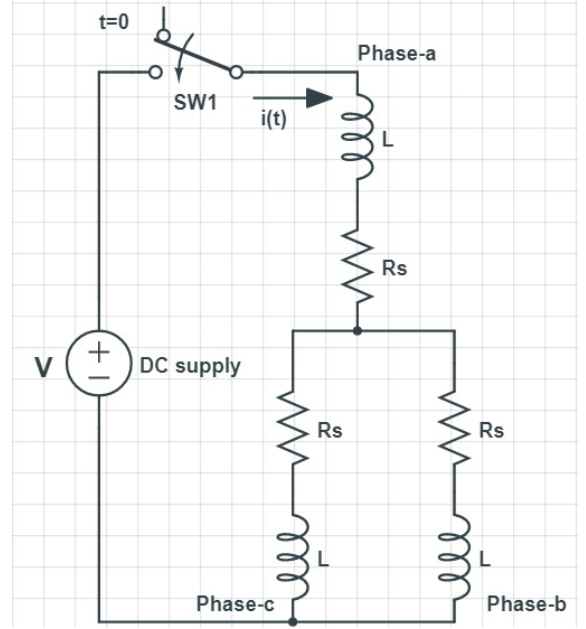
Figure 12. Equivalent circuit of tested machine under step DC test.